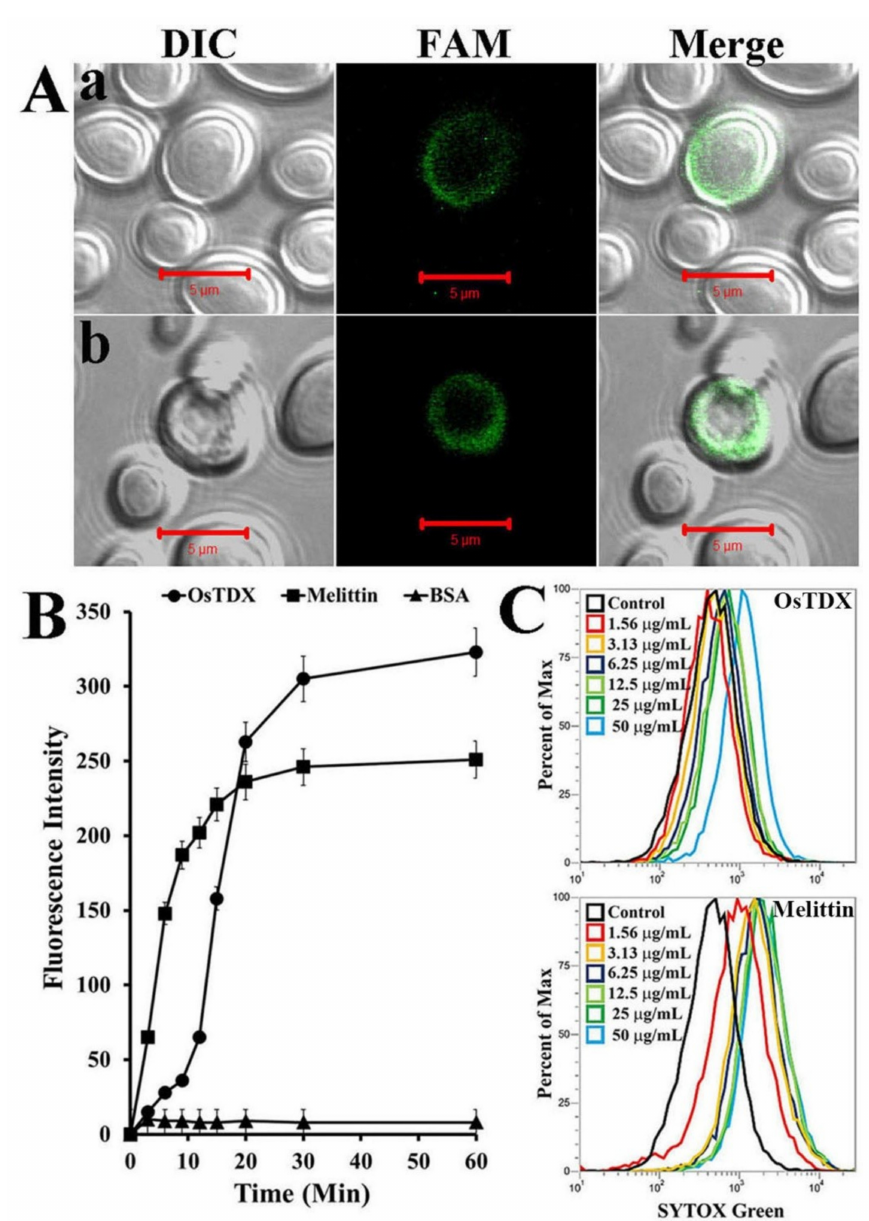
Figure 4. Cellular distribution and SYTOX-Green uptake of OsTDX in Candida albicans cells. ( A ) After 30 min incubation in the presence of FAM-labeled melittin ( a ) or OsTDX ( b ), C. albicans cells were washed with PBS buffer (pH 7.2) and observed under CLSM in differential interference contrast (DIC) and fluorescence conditions. ( B ) Time-dependent uptake of SYTOX-Green was measured using a fluorescence spectrophotometer after treatment of SYTOX-Green-pretreated C. albicans cells with melittin, OSTDX, and BSA. ( C ) After 30 min incubation in the presence of OsTDX or melittin at various concentrations, intracellular uptake of SYTOX-Green in C. albicans cells was measured by flow